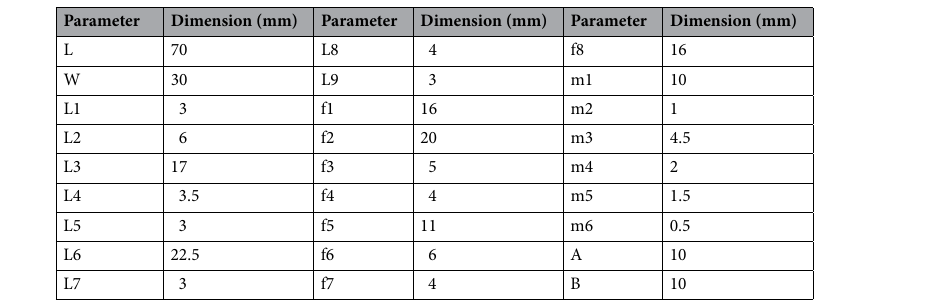
Table 3. Dimensions of the antenna prototype.